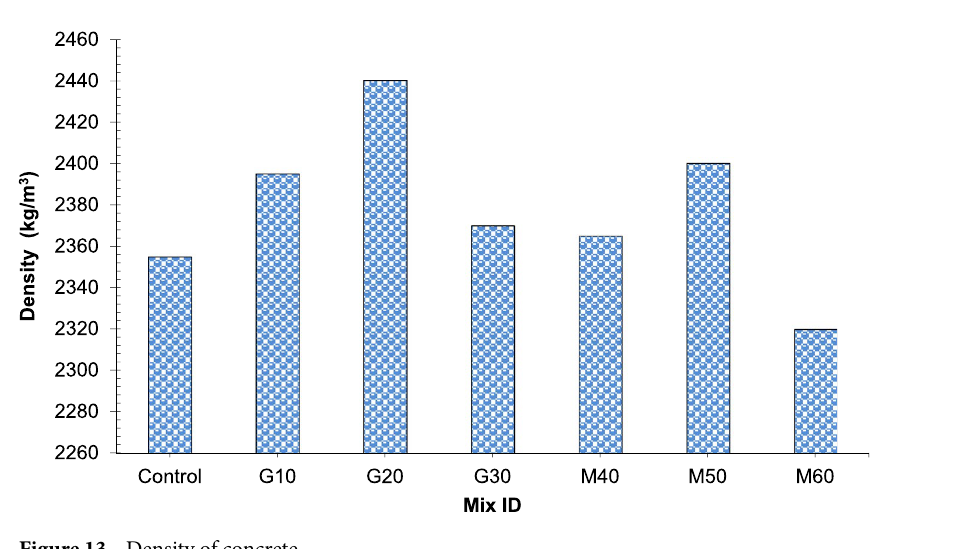
Figure 13. Density of concrete.